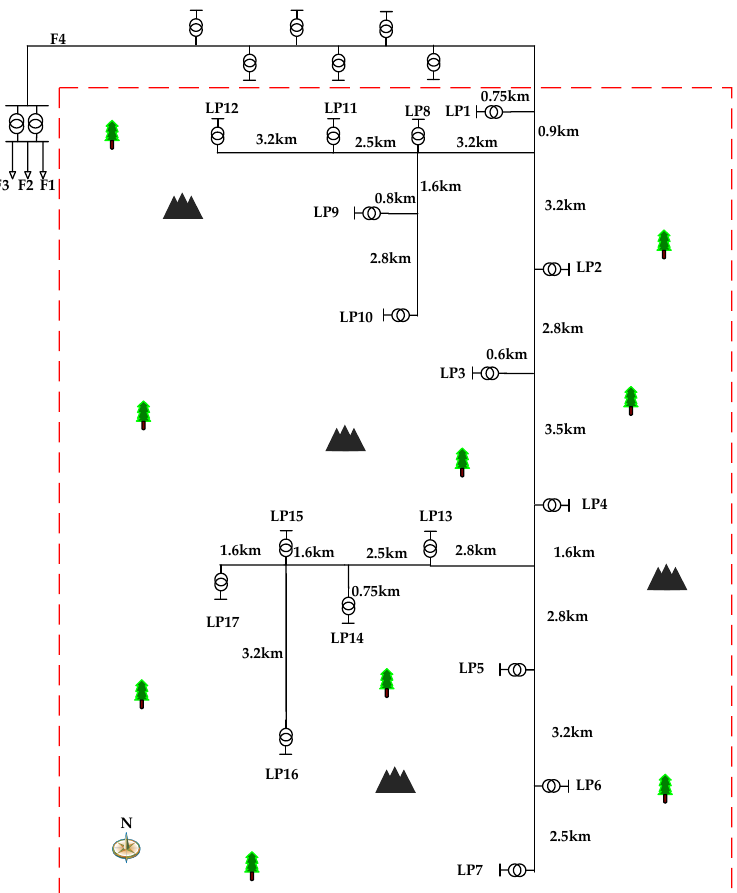
Figure 5. Feeder of the test system with poor or lack of coverage of communication networks.